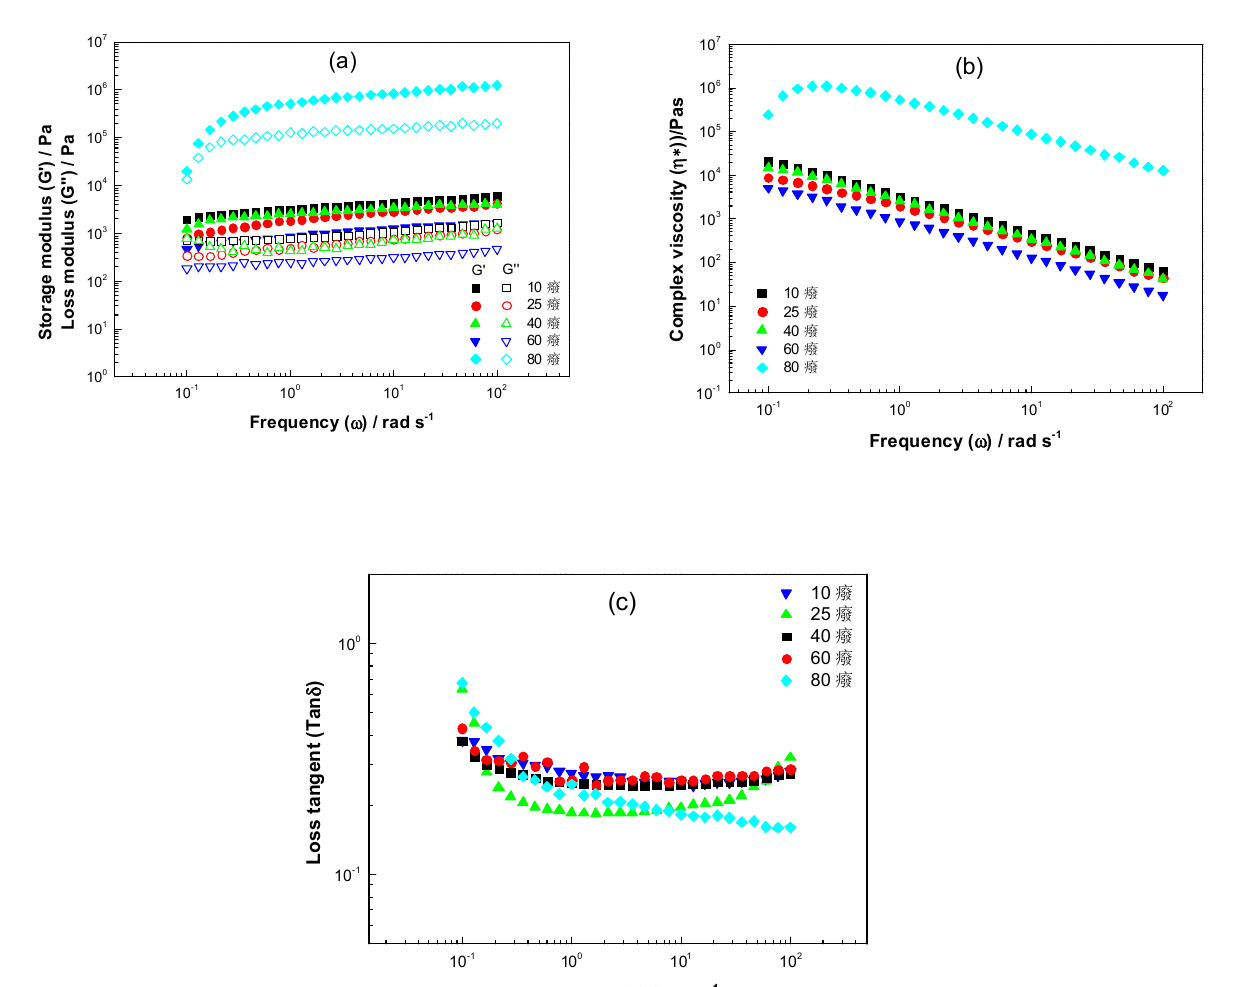
Figure 4. Viscoelastic parameters in function of the frequency of hydrocolloids from Pereskia bleo leaves. ( a ) storage G (cid:48) and loss G (cid:48)(cid:48) modulus, ( b ) complex viscosity ( η ∗ ), and ( c ) Tan δ . Table 4. The viscoelastic properties of hydrocolloids from Pereskia bleo leave in a frequency sweep at 1